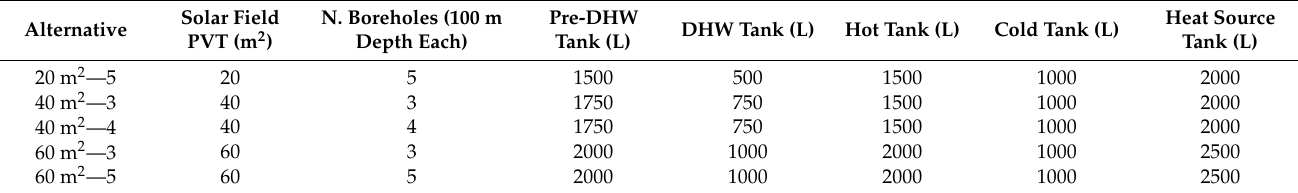
Table 2. Size of the solar and ground fields, and of the storage tanks for the alternatives considered. Solar Field Alternative PVT (m 2 )